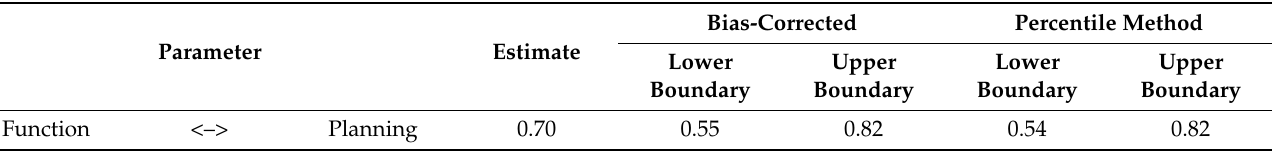
Table 5. Regular exercise behavior—hindrance—bootstrap 95% confidence interval table of related coefficients.